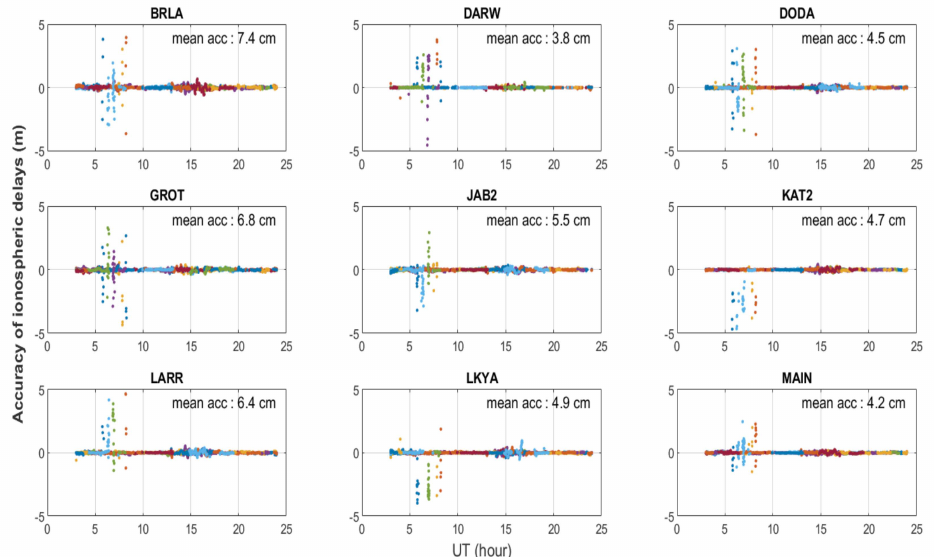
Figure 7. Plots showing the differences between the interpolated and measured ionospheric correc- tions as function of time at the nine NT CORS GNSS stations on 6 May 2021. The colours represent for different satellite observations.